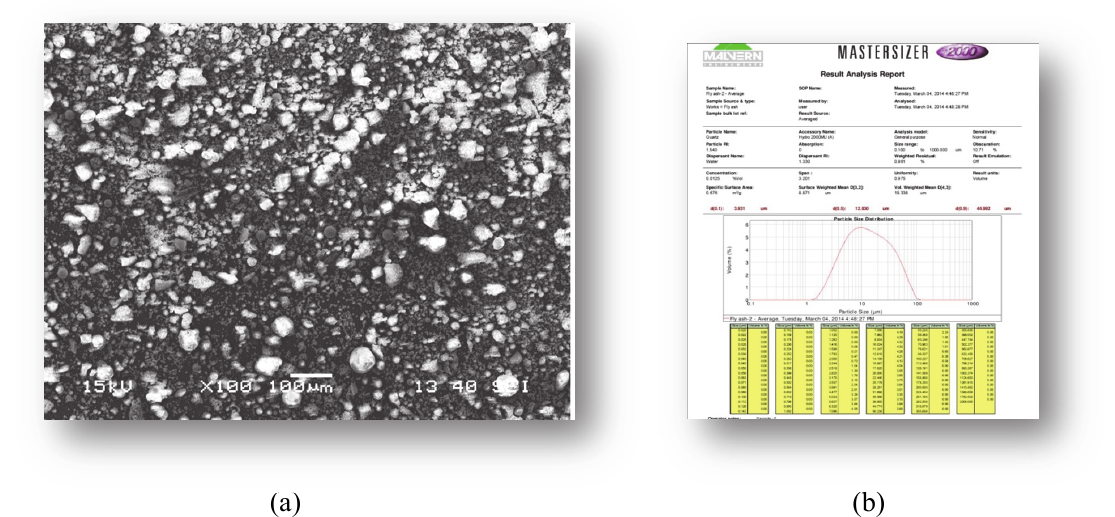
Fig. 1. (a) SEM micrograph and (b) Particle size analysis of as received waste flyash